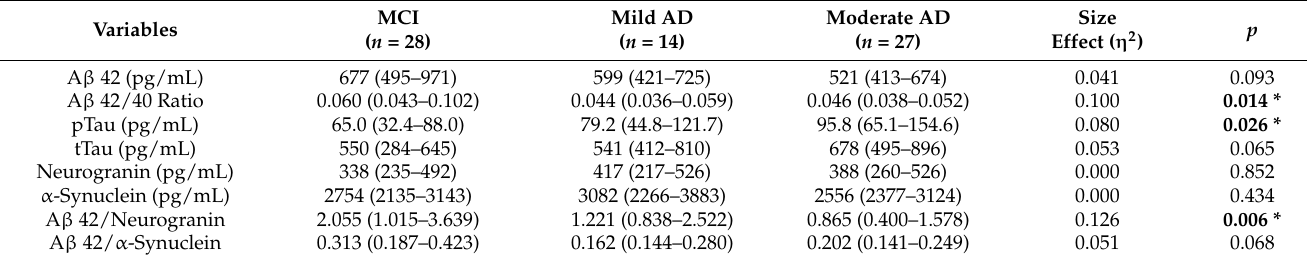
Table 4. CSF levels of AD-related biomarkers (i.e., A β 42, pTau, tTau, A β 42/40, A β 42/pTau and A β 42/tTau) and biomarkers related to synaptic dysfunction (i.e., neurogranin, α -synuclein, A β 42/neurogranin and A β 42/ α -synuclein) in AD subgroups (i.e., MCI, mild AD and moderate AD).